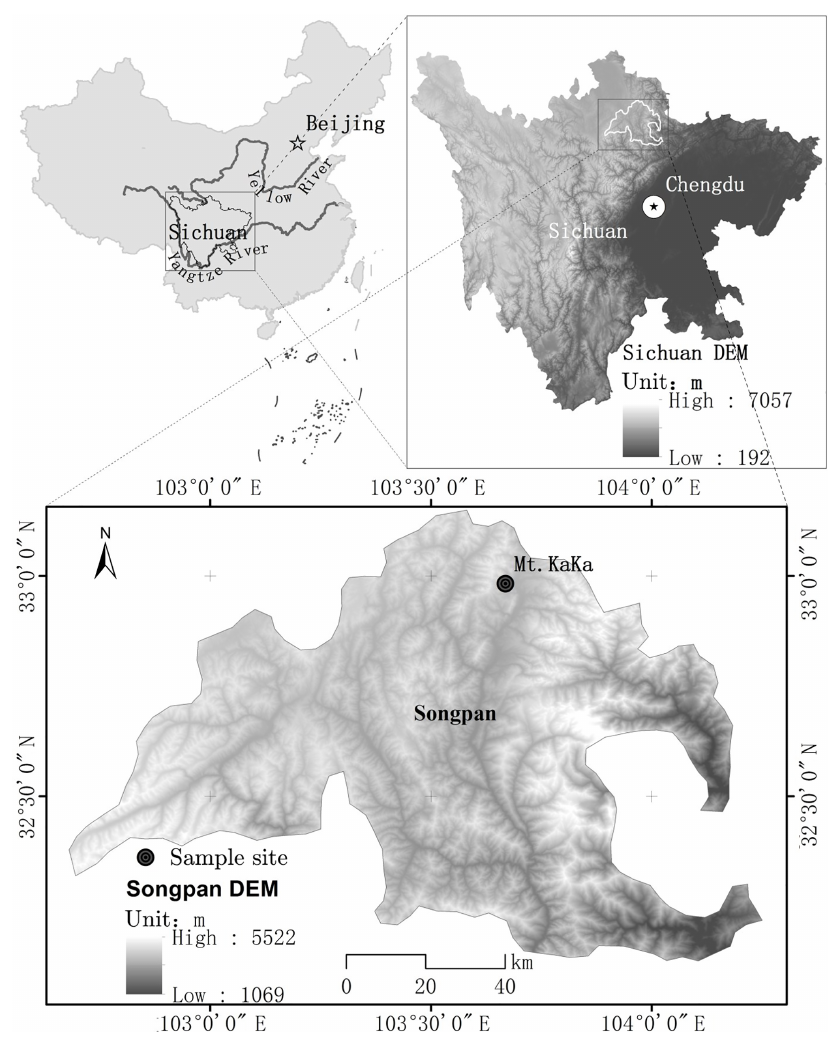
Figure 1. Location of the study